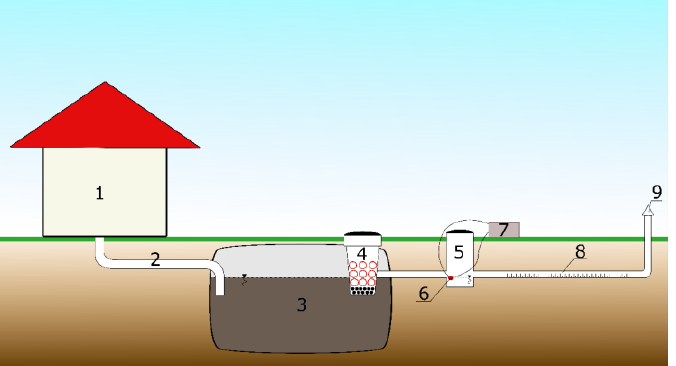
Figure 1. Simplified diagram of the DWTP as a test stand: (1) detached house, (2) the duct, (3) septic tank, (4) filter basket, (5) control well, (6) measuring probe, (7) data logger, (8) infiltration drainage, (9) exhaust